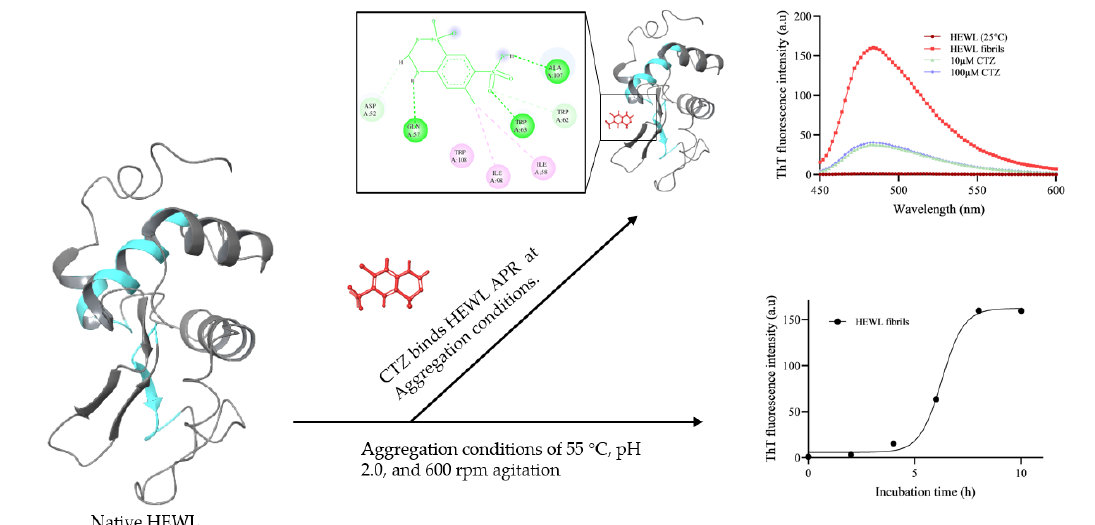
Figure 11. Mechanistic description of HEWL fibrillation and inhibition by CTZ.